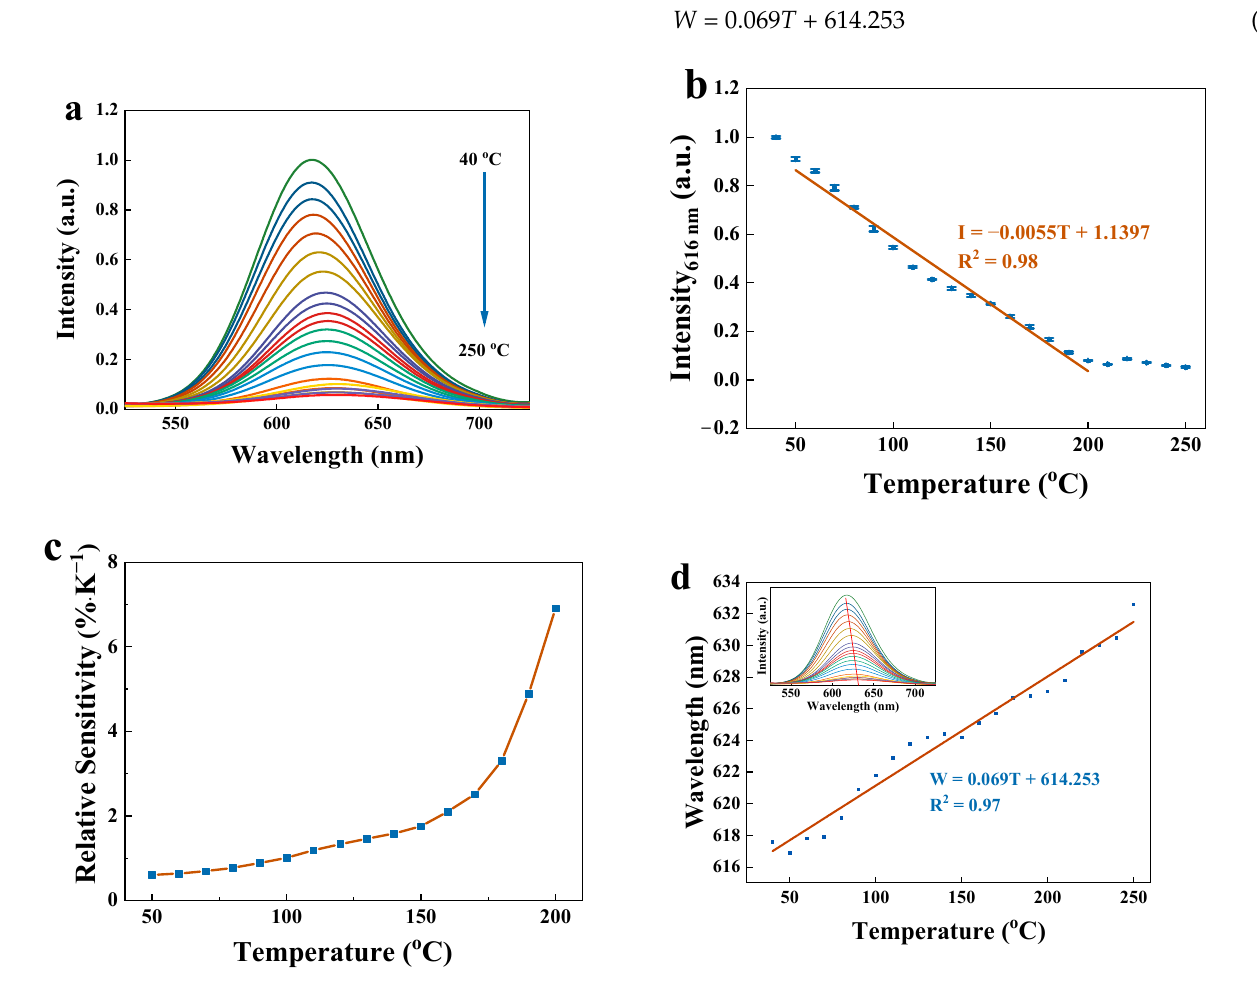
Figure 3. ( a ) Temperature-dependent fluorescent emission spectra of Zn-CYMPN ⊃ DPEE-1. ( b ) Flu- orescence intensity at 616 nm, and the fitting line with temperature of 50~200 °C. ( c ) The relative sensitivity for intensity. ( d ) Wavelength at the maximum fluorescent emission and the fitting line with temperature of 40~250 °C (insert: temperature-dependent fluorescent emission spectra and the shift in wavelength corresponding to the maximum fluorescence emission intensity).